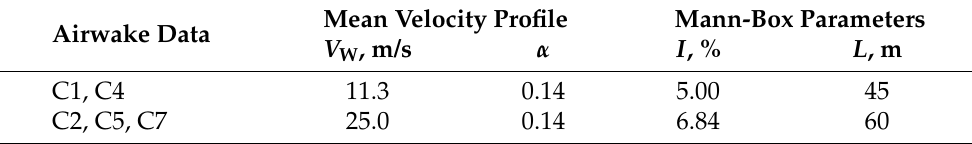
Table 2. Maritime inflow